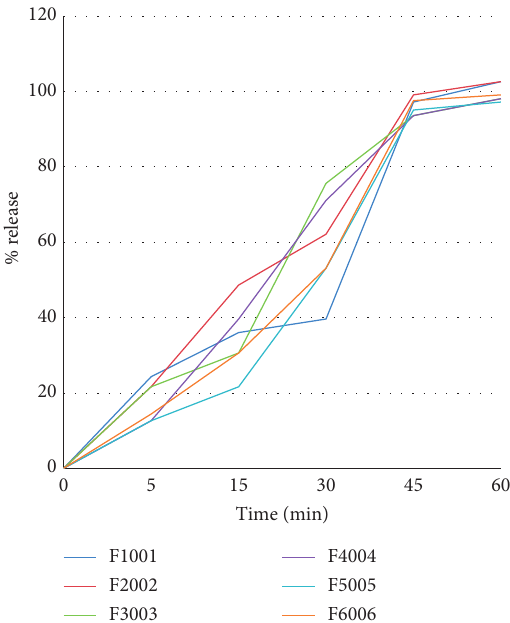
Figure 4: Dissolution profile of ethambutol hydrochloride 100mg tablet batches samples included in the